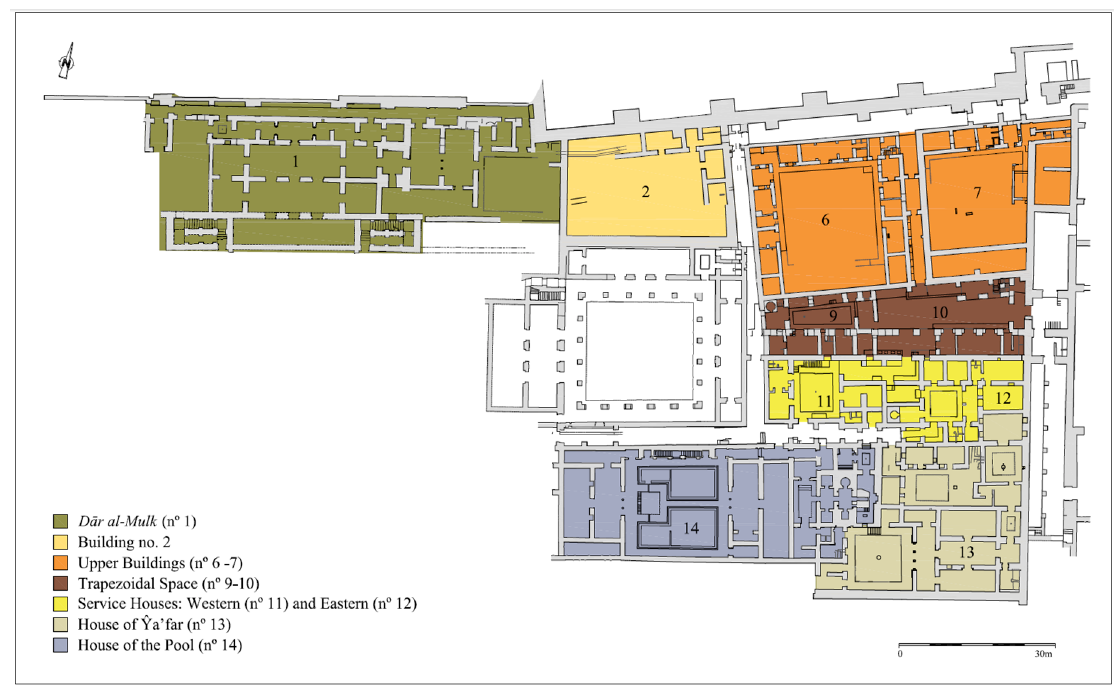
Figure 2. Private sector. Own elaboration on the plan of Vallejo Triano (2016a, Figure 2).